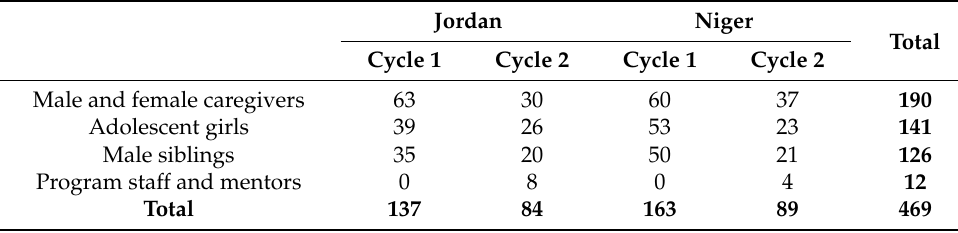
Table 1. Qualitative evaluation samples in Jordan and